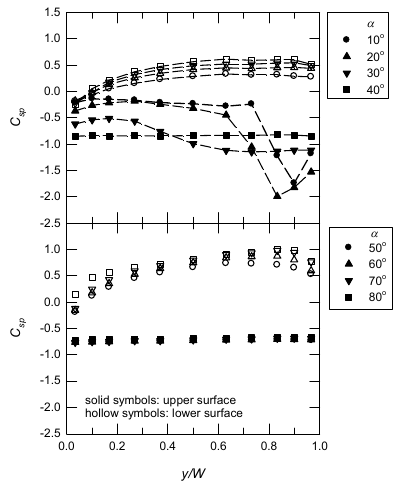
Figure 7. Mean spanwise pressure distributions at x/L = 0.5; β = 0°.